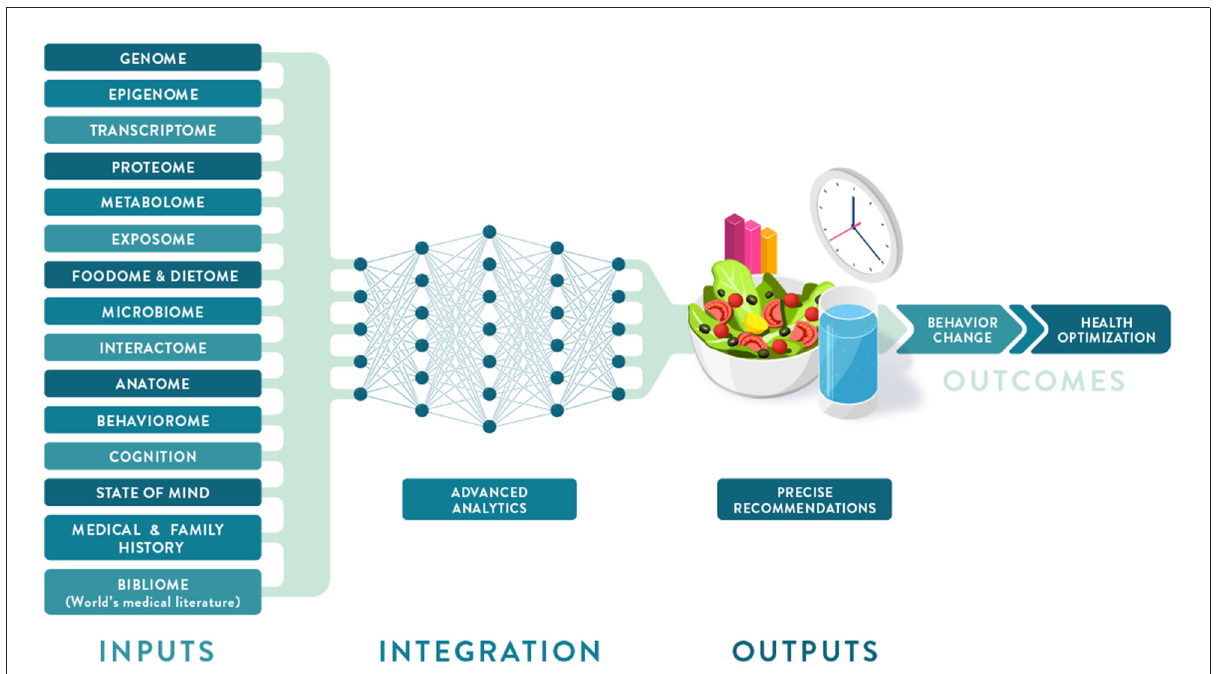
FIGURE2 Deep phenotyping and multiomic integration in Precision Nutrition. Multiple data layers that make up an individual deep phenotyping profile are integrated and analyzed using a neural network approach to provide optimized dietary recommendations leading to behavior change and improved health